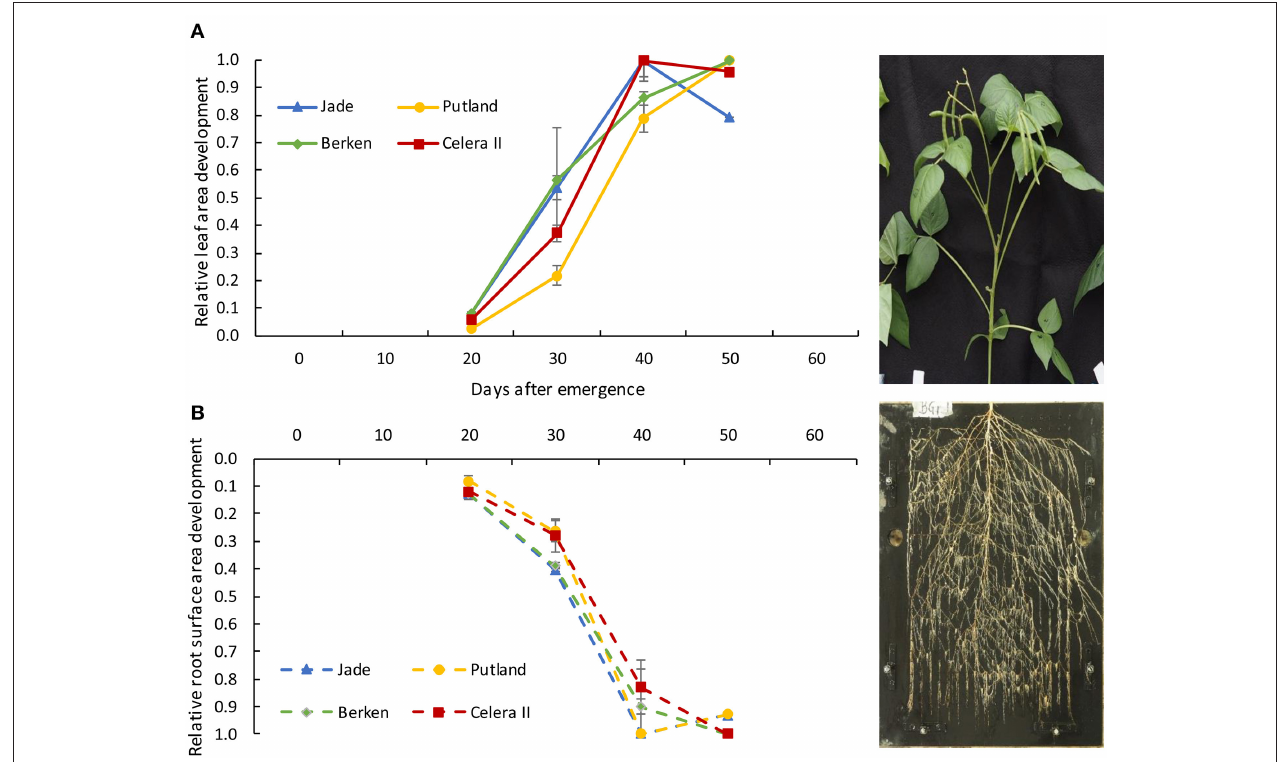
FIGURE 5 | Relative development of leaf area (A) and root surface area (B) from 20 days to 50 days of plant growth for four varieties; Jade, Putland, Berken and Celera II. Error bars indicate +/- standard error of means. The photograph represents the figures for the directional growth of shoot (A) and root (B)